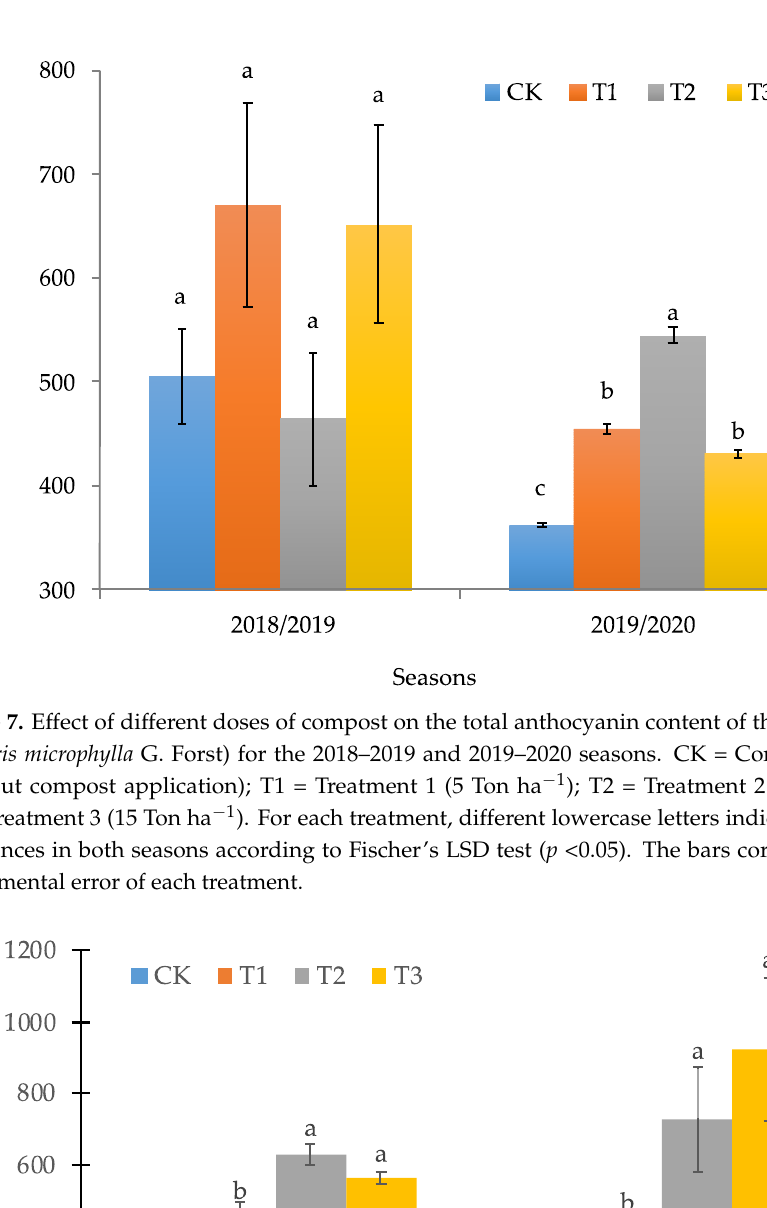
10 of 16 Figure 6. Effect of different doses of compost on the total polyphenolic content of calafate fruit ( Ber ‐ beris mycrophilla G. Forst) for the 2018–2019 and 2019–2020 seasons. CK = Control treatment (without compost application); T1 = Treatment 1 (5 Ton ha − 1 ); T2 = Treatment 2 (10 Ton ha − 1 ); T3 = Treatment 3 (15 Ton ha − 1 ). For each treatment, different lowercase letters indicate significant differences in both seasons according to Fischer’s LSD test ( p < 0.05). The bars correspond to the experimental error of each treatment. Figure 7 shows the total anthocyanin content (TAC) in the calafate fruit for the dif ‐ ferent compost treatments in the 2018–2019 and 2019–2020 seasons. For the first season under evaluation, the same behavior as the CPT was observed, not registering significant differences between CK, T1, T2, and T3, whose values averaged 573 mg cyanidin ‐ 3 ‐ gluco ‐ side/100 g fw. For the second season, more noticeable effects were observed, although there was a decrease in TAC in most treatments. T2 was the one that registered the highest